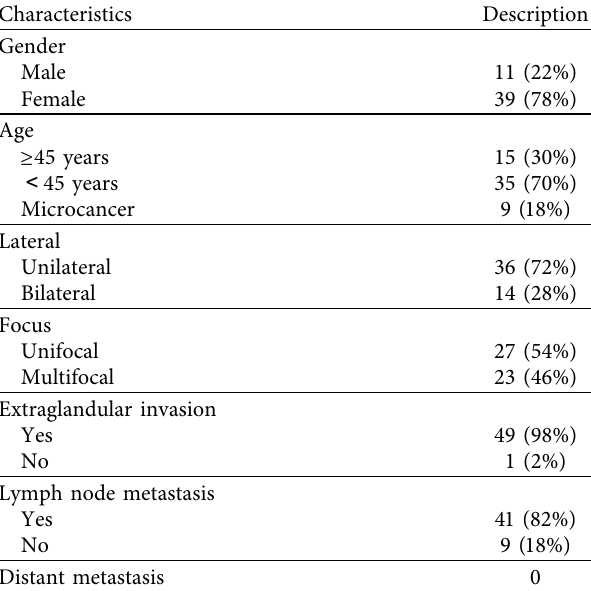
Table 1: Clinicopathological features of patients with papillary thyroid carcinoma ( n �